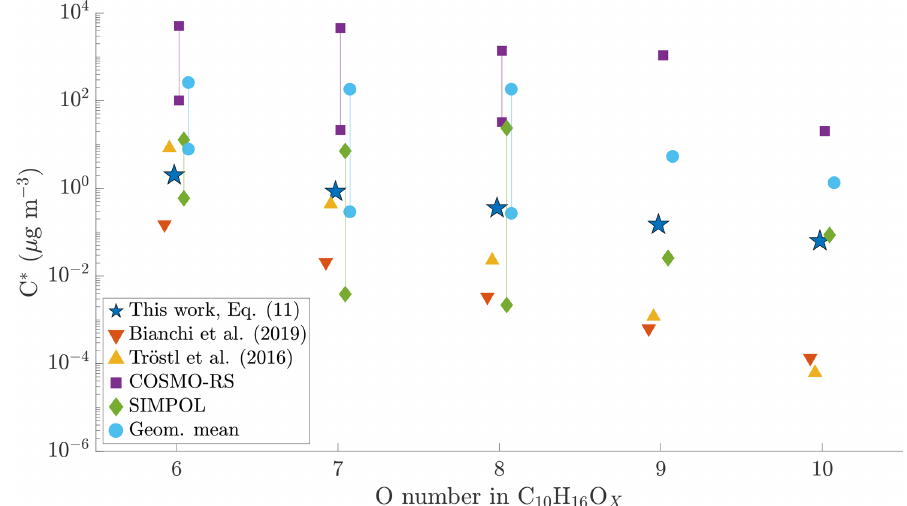
Figure 8. Comparison of different volatility estimates and parameterizations. SIMPOL and COSMO-RS are from Kurtén et al. (2016): COSMO-RS is the geometric mean of their four different COSMO-RS estimates. Geom. mean is the geometric mean of SIMPOL and COSMO-RS as recommended by Kurtén et al. (2016). For compounds with six to eight oxygen atoms, Kurtén et al. (2016) used multiple candidate isomers: values are given both for that with the highest and for that with the lowest saturation concentration. For the parameteriza- tions from Tröstl et al. (2016), Bianchi et al. (2019) and Eq. (11), all structural isomers get the same value, and thus only one is given. All values are saturation vapour concentrations in µgm − 3 . The values from Kurtén et al. (2016) are calculated at 298.15K, Tröstl et al. (2016) at 293K, Bianchi et al. (2019) at 300K and Eq. (11) at chamber temperature, approx.